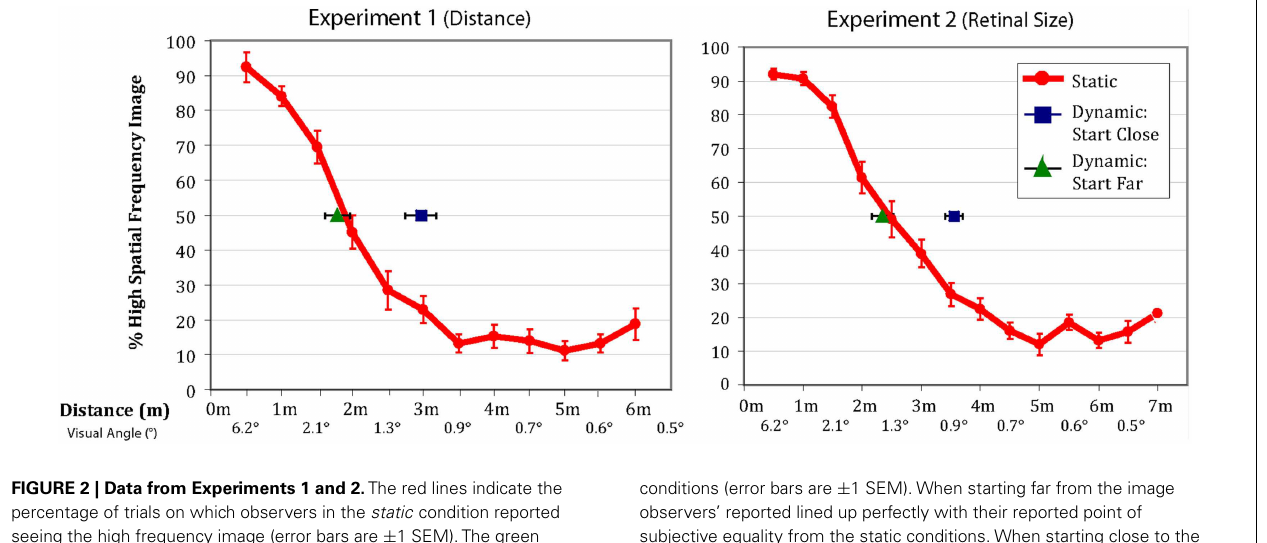
FIGURE 2 | Data from Experiments 1 and 2. The red lines indicate the percentage of trials on which observers in the static condition reported seeing the high frequency image (error bars are ± 1 SEM).The green triangles and blue squares show the distance/visual angle at which observers reported the point of subjective equality in the dynamic